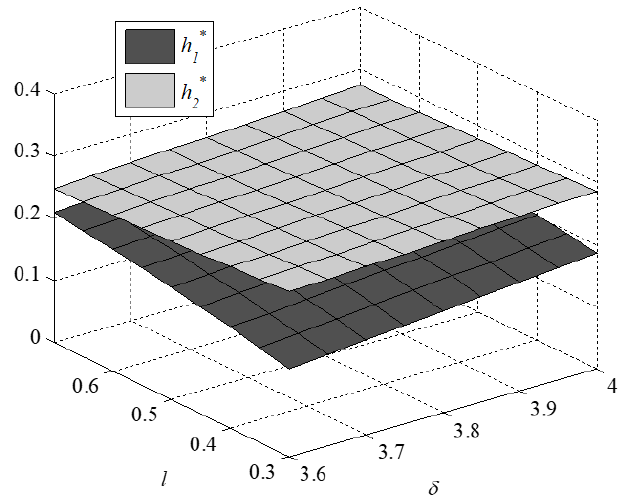
Figure 1. Changes in green technology innovation level (GTIL).